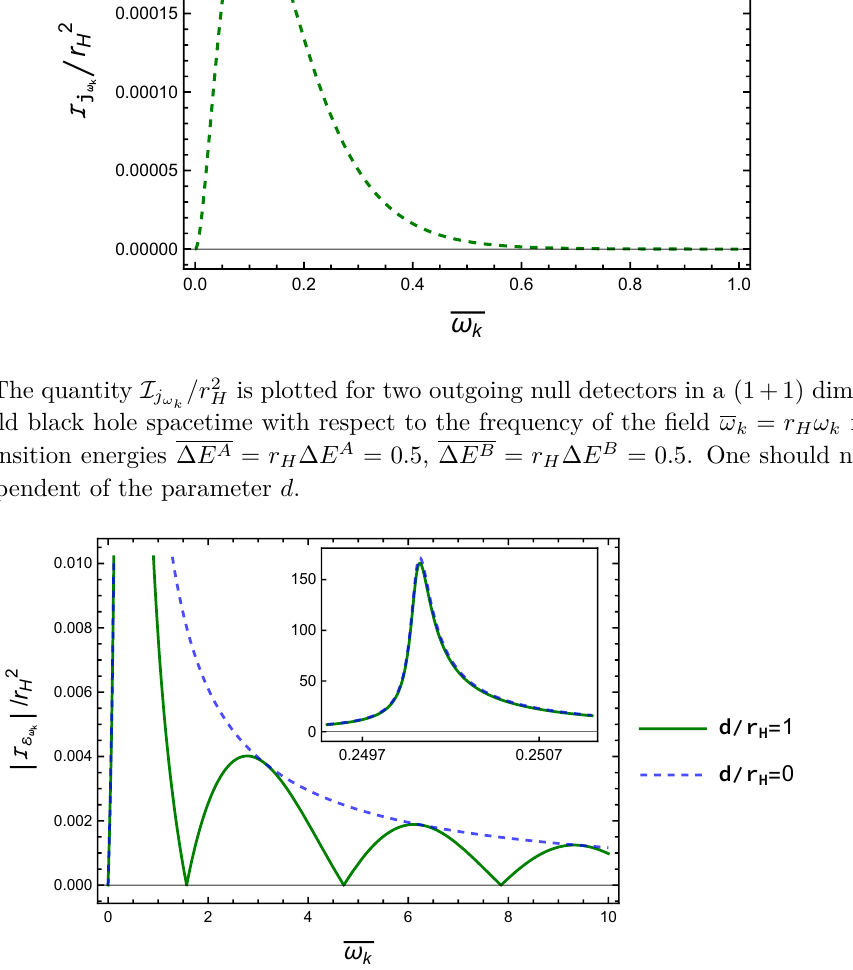
is plotted for two outgoing null detectors in a (1+1) dimensional | /r 2 H ωk ∆ E A = 0 . 5 , ∆ E B = r H